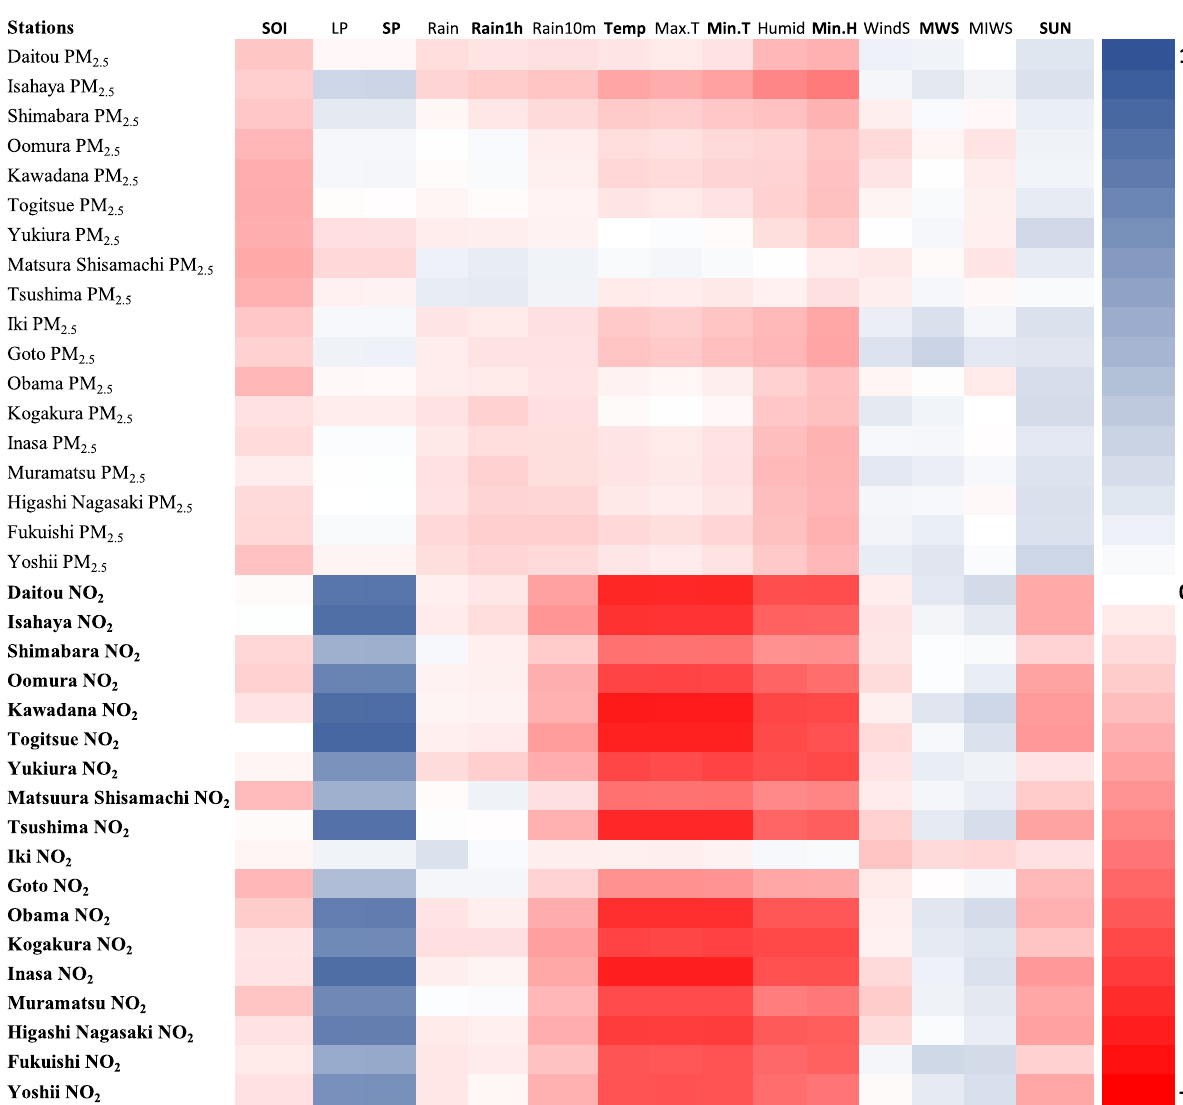
Figure 4. Heatmap represents the correlation between climatic factors and PM 2.5 and NO 2 air pollution data for 18 monitoring stations in Nagasaki Prefecture, Japan. * SOI = Souther Oscillation Index, LP = Average local pressure, SP = Average sea level pressure, Rain = Daily Precipitation, Rain1h = Maximum 1-h precipitation, Rain10m = Maximum 10 min precipitation, Temp = Average Temperature, Max.T = Maximum Temperature, Min.T = Minimum Temperature, Humid = Average humidity, Min.H = Minimum humidity, WindS = Average wind Speed, MWS = Minimum wind speed, MIWS = Maximum instantaneous wind speed, SUN = Sunlight